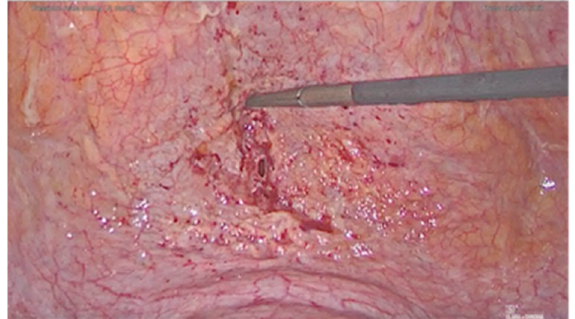
Figure 1. Uroperitoneum.